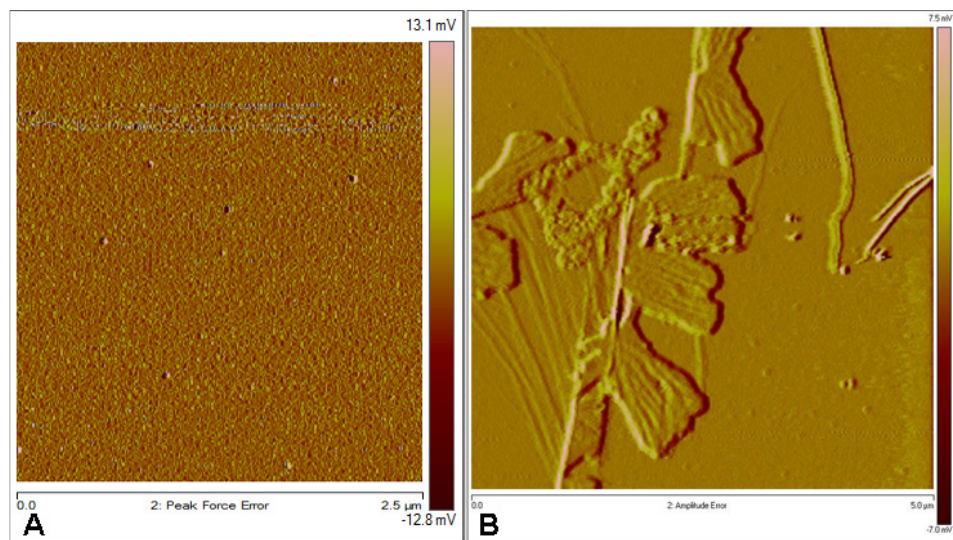
Figure 5. Atomic force microscopy image of the Langmuir-Blodgett monolayer ( A ) and part of the monolayer in the border of the film ( B ).